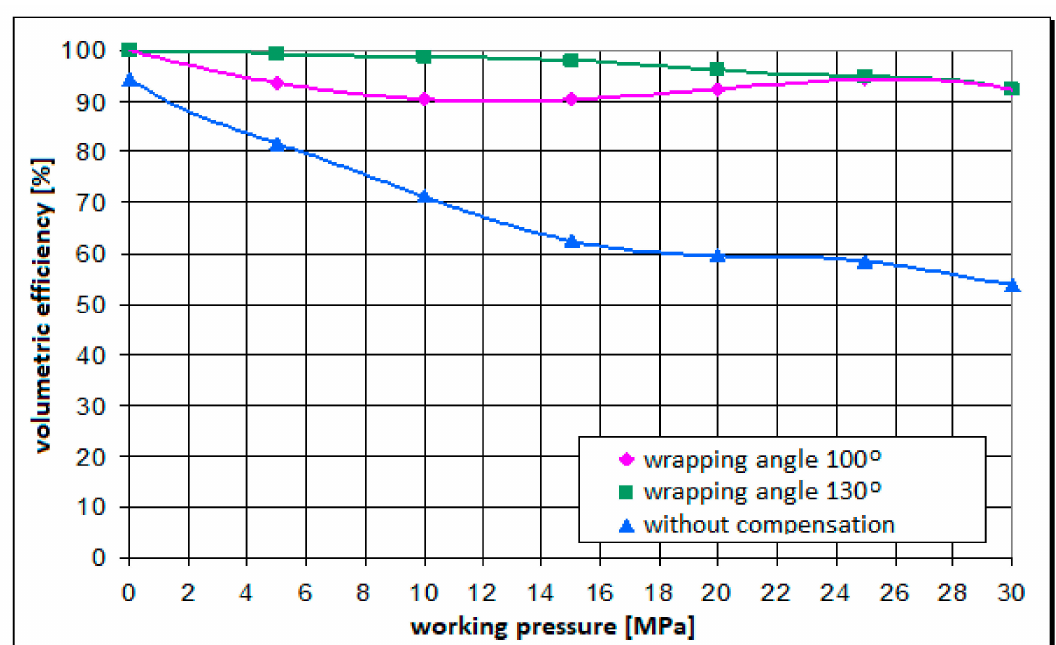
Figure 2. Volumetric efficiency for the conventional pump and for the prototype pumps with circumferential backlash compensation having the wrapping angles ϕ o = 100 ◦ and 130 ◦ , with n = 500 rev/min. [1].